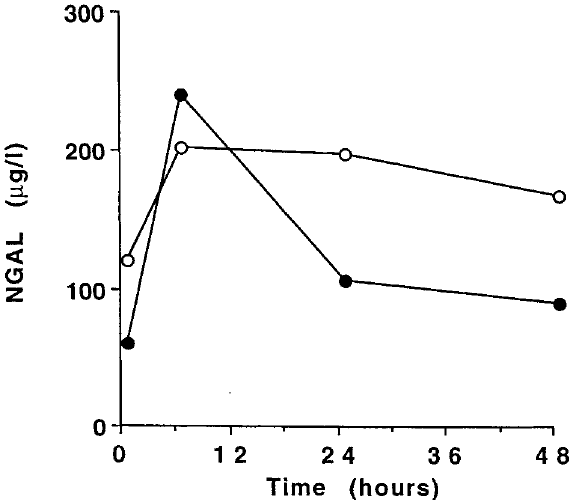
FIG. 1. Median concentration of plasma-NGAL in samples from patients operated with ECC ( d ) and without ECC ( s ).